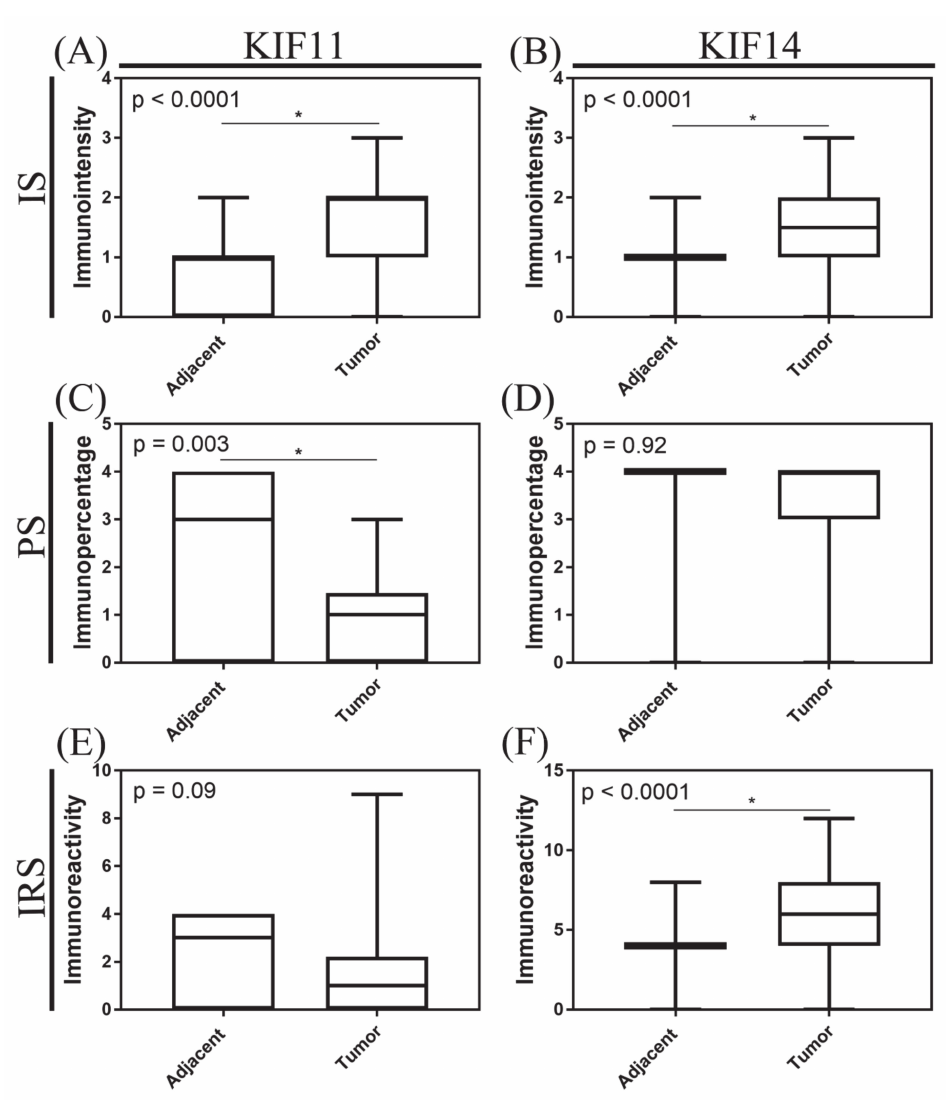
Figure 2. Immunoexpression of KIF11 and KIF14 in pancreatic ductal adenocarcinoma. The X axis of the plot represents histologically normal tissue that was adjacent to tumor tissue vs. cancer tissue, and the Y axis represents immunointensity, IS ( A , B ); immunopercentage, PS ( C , D ); or immunoreactivity, IRS ( E , F ). The top and bottom of the error bars represent the maximum and minimum values of data, respectively. The asterisk indicates statistical significance (* p < 0.05, Mann–Whitney